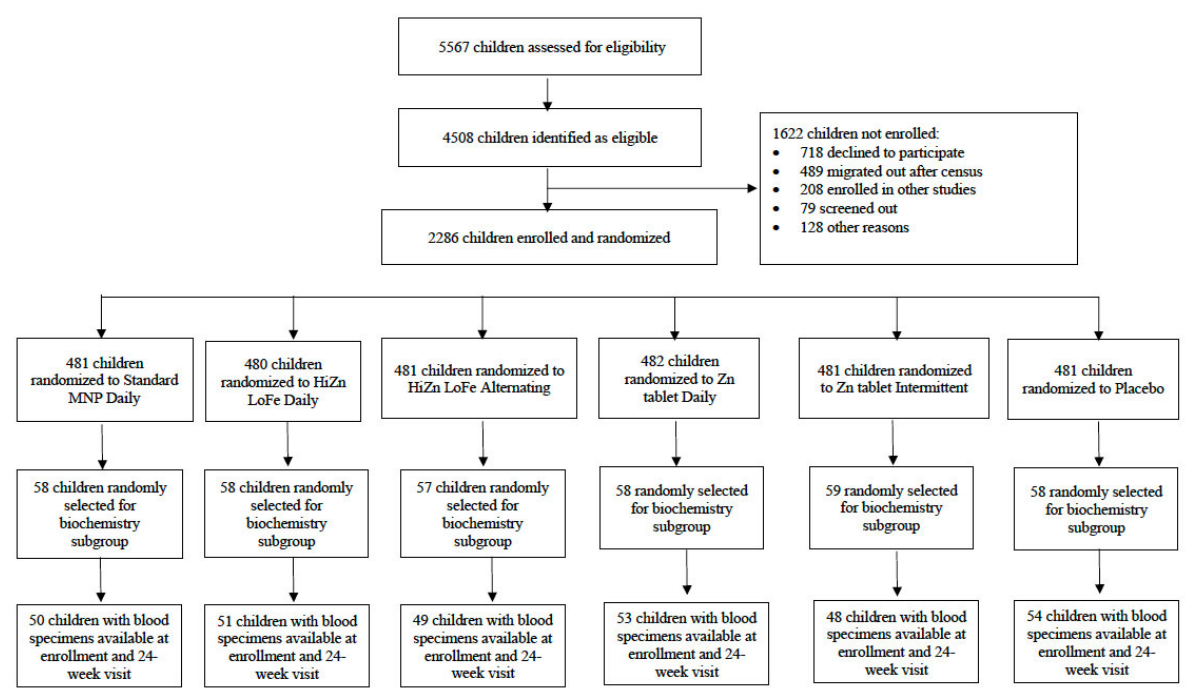
Figure 1. Flowchart of study participants. Baseline characteristics of the child participants and their families are shown in Table